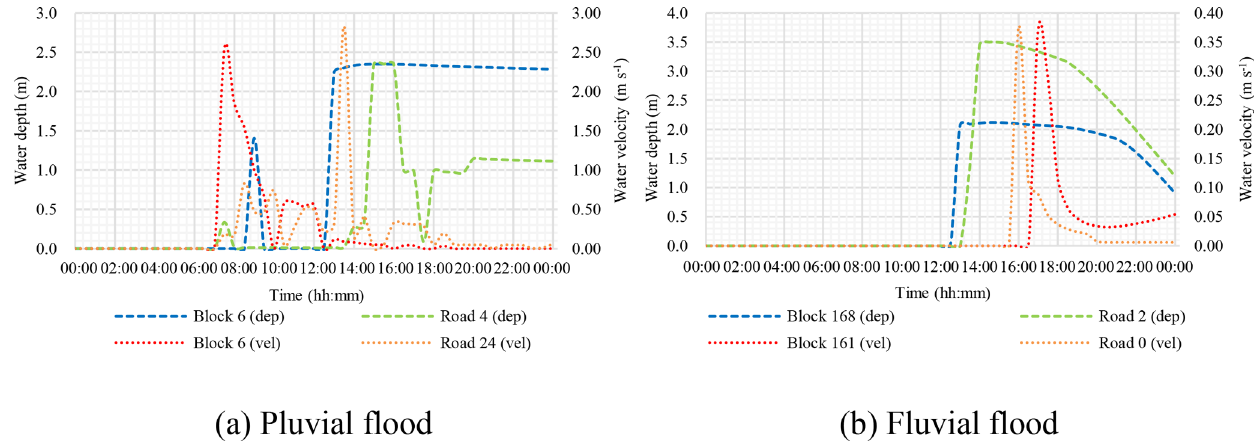
Figure 10. Changes in the surface water depths and velocities for eight severely flooded areas. The “dep” indicates water depth, and “vel” indicates water velocity.